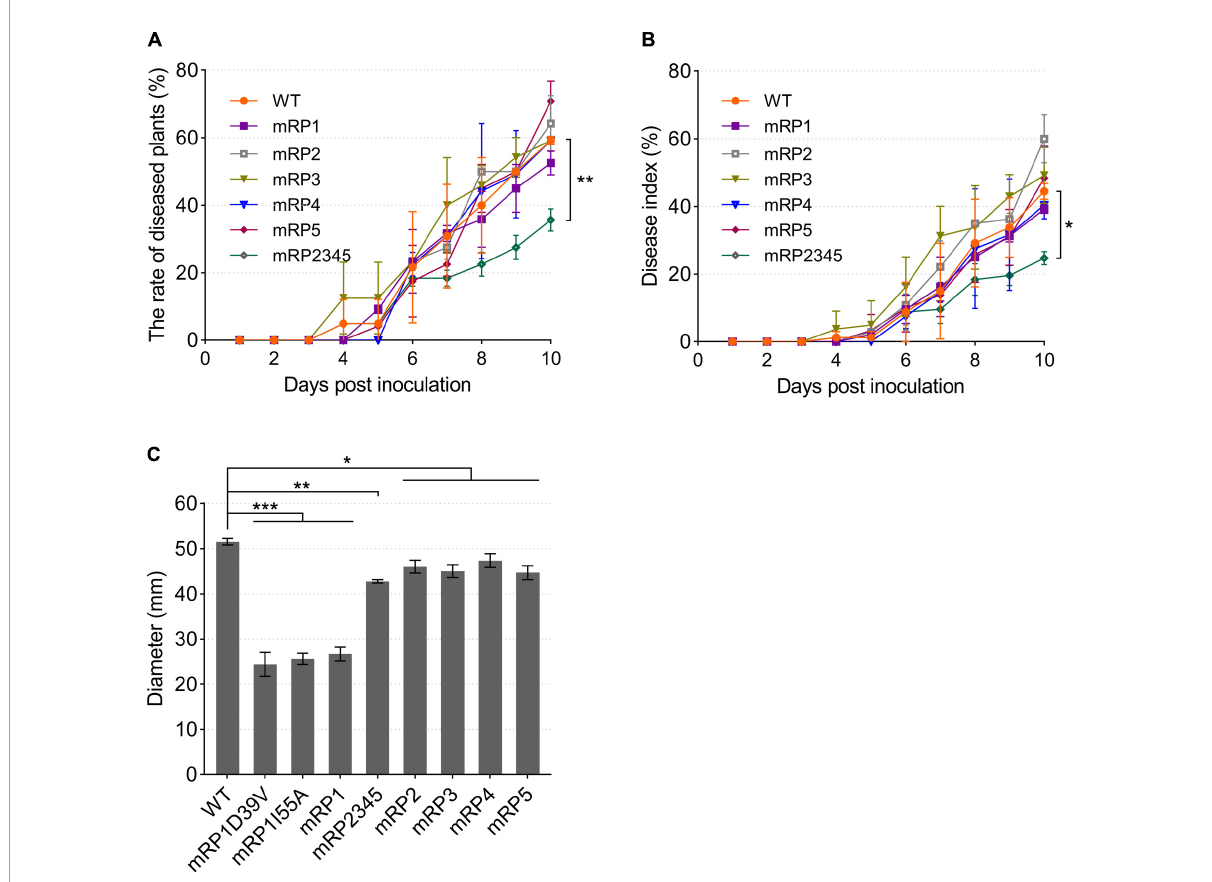
FIGURE8 Pathogenicity and swimming motility of R . solanacearum strains. (A,B) Mutant mRP2345 showed significantly reduced virulence in tomato plants. Fresh cultures of the strains were used to infect tomato plants. Once infected, the numbers of diseased plants (left panel) and the disease severity rating for each plant (right panel) were recorded daily. The rate of diseased plants is the ratio of the number of diseased plants to the total number of plants. The disease index (DI), DI = P ( severity rating × number of plants in that rating )/( total number of plants × 4 ) . (C) The swimming motility patterns of the R . solanacearum strains were assessed on semisolid motility medium. WT, wild-type strain GMI1000; mRP1, mutant in which the acpP1 gene is replaced with E. coli acpP ; mRP2, mutant lacking gene acpP2 ; mRP3, mutant lacking gene acpP3 ; mRP4, mutant lacking gene acpP4 ; mRP5, mutant lacking gene acpP5 ; mRP2345, mutant lacking genes acpP2 , acpP3 , acpP4 , and acpP5 ; mRP1D39V, mutant in which Asp39 of AcpP1 is mutated to Val; mRP1I55A, mutant in which Ile55 of AcpP1 is mutated to Ala. Significant differences are indicated as *** P < 0.001, ** P < 0.01, and * P <